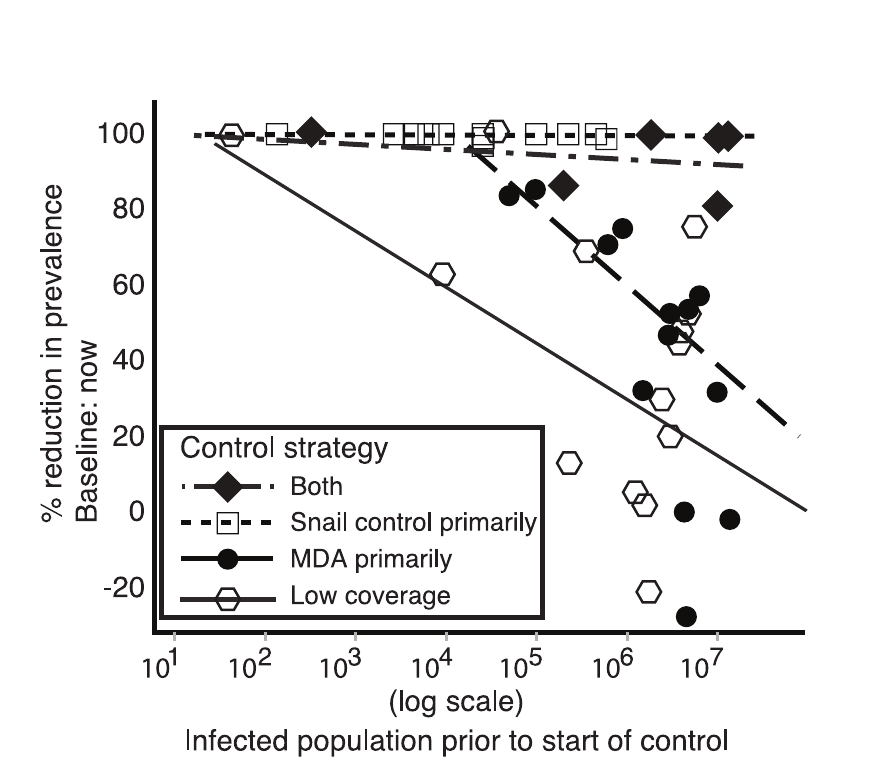
Fig 7. Sensitivity of schistosome prevalence reduction to the infected population size before the control program began.